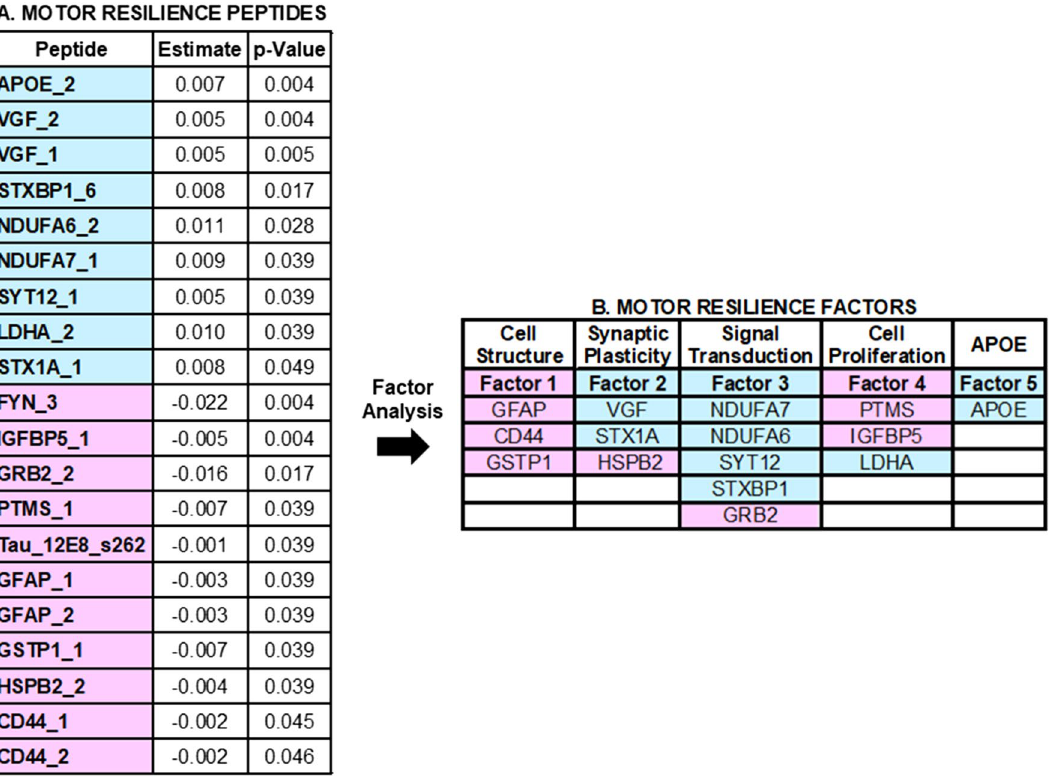
Figure 4. Cortical Proteotypic Peptides and Residual Motor Decline. ( A ) Shows the 20 proteotypic peptides which were associated with the annual rate of residual motor decline. Each row in Table A shows the results of a separate linear mixed-effect model that included terms for a specific peptide, demographics and 10 indices of brain pathologies. Each row shows the strength of the association [Estimate and corrected p-Value (false discovery rate 5%)] of a single peptide with the annual rate of motor decline (Time*peptide). Peptides are ordered by those for which a higher level was associated with slower motor decline (blue) and those for which a lower level was associated with slower motor decline (pink) and by strength of their association with motor decline). ( B ) shows the clustering of the peptides into five factors. Each factor may represent a distinct biological